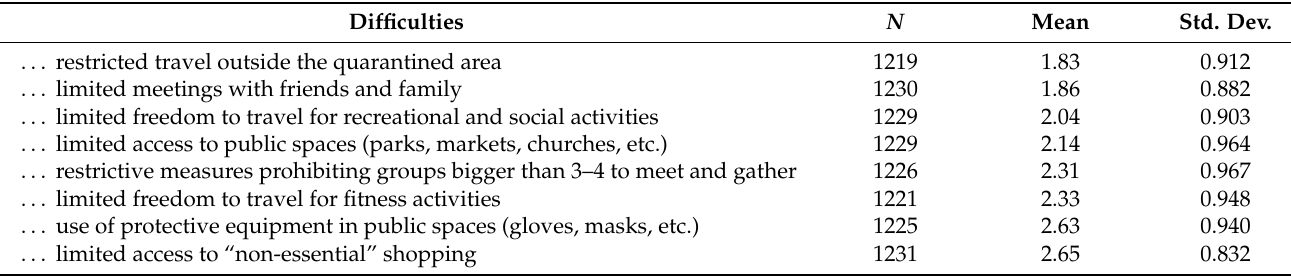
Table 4. Description of measures implemented by authorities.